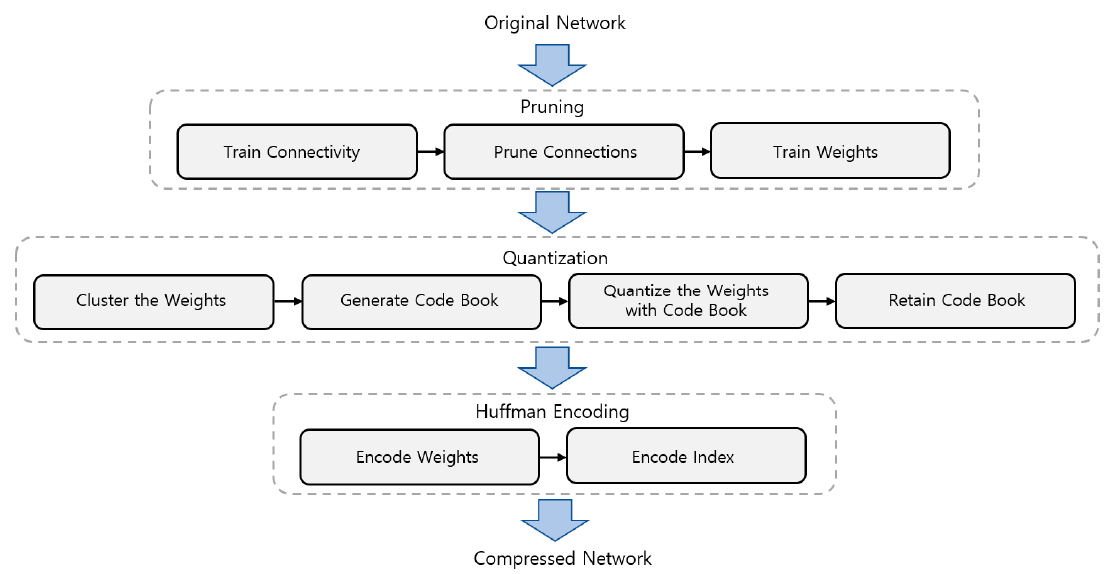
Figure 2. A summary of the three stages in the compression pipeline proposed in [10]: pruning, quantization, and Huffman encoding. The input is the original network and the output is the compressed network.